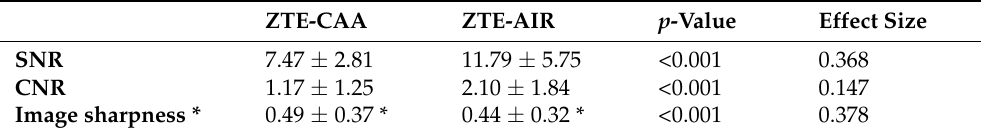
Table 2. Comparison of signal-to-noise ratio (SNR), contrast-to-noise ratio (CNR), and image sharp- ness between ZTE-CAA and ZTE-AIR. ZTE-CAA ZTE-AIR p -Value Effect Size SNR Image sharpness * 0.49 ± 0.37 * 0.44 ± 0.32 * <0.001 0.378